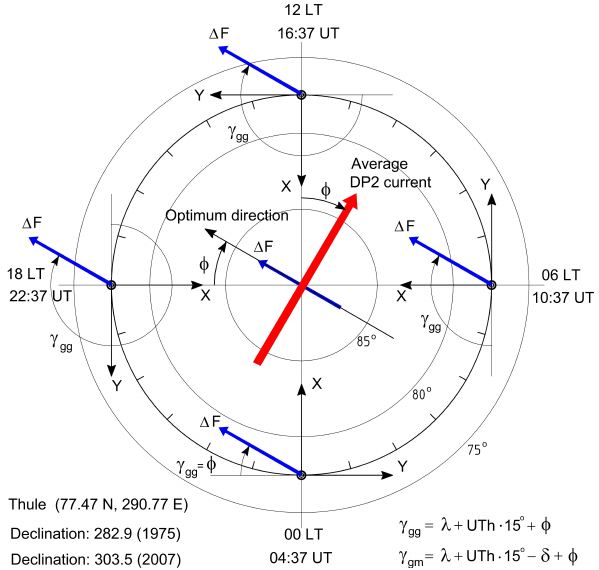
Fig. 2*. Illustration of projection angles for various hours (00:00, 06:00, 12:00, 18:00LT) of the day for a station (Thule) in the north- ern polar